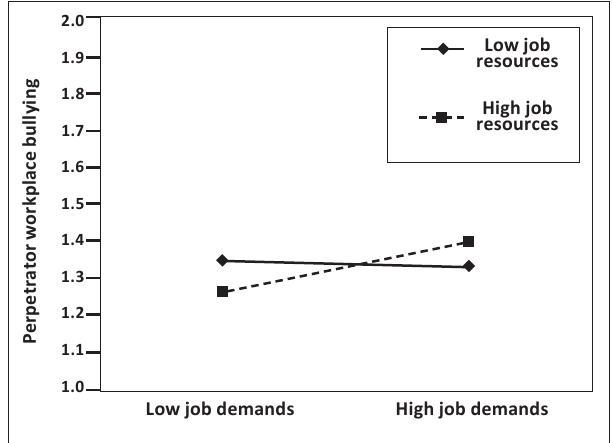
FIGURE 1: Interaction effects of job demands and job resources on perpetrators’ reports of workplace